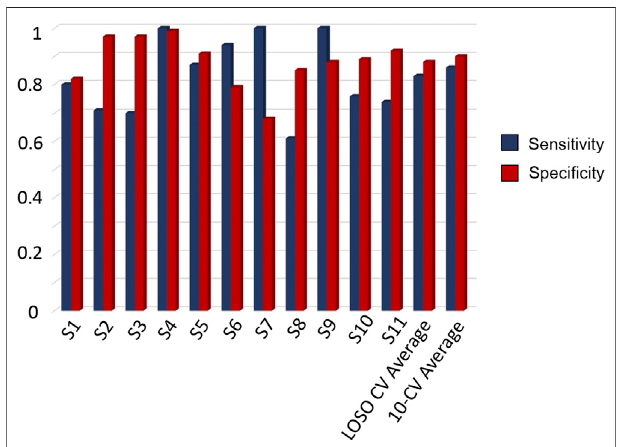
FIGURE 4 | Resulted sensitivity and speci fi city scores per patient from LOSOCV,alongwiththeaveragescoresderivedbytheLOSOCVand10-CV, based on single-window detection.